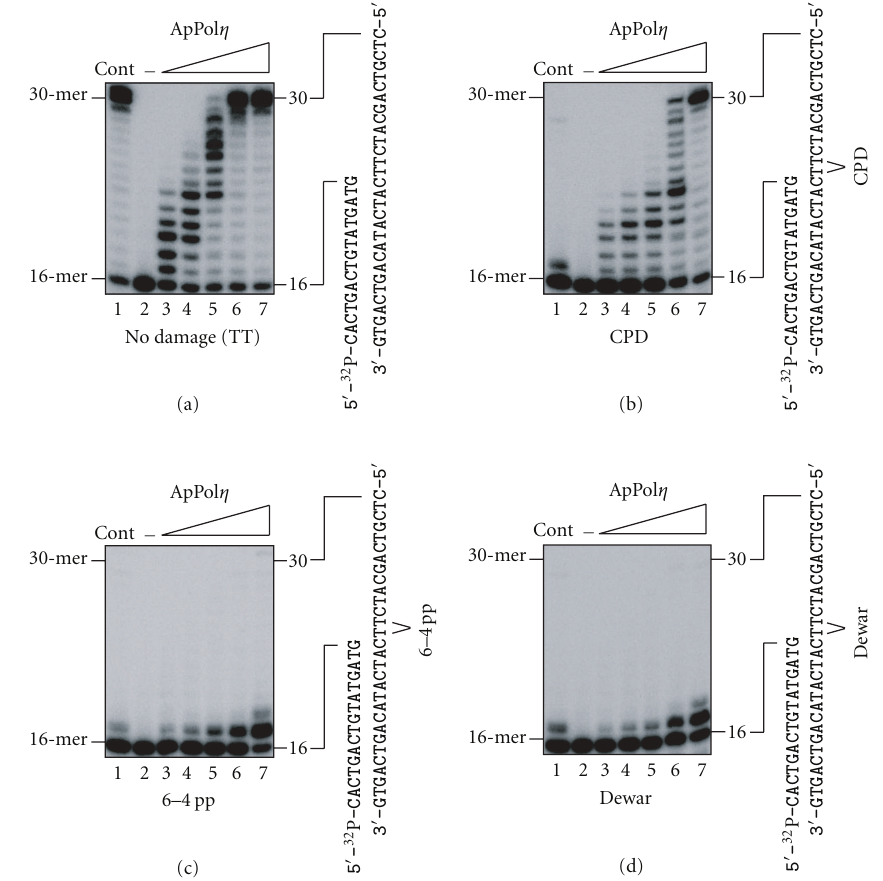
Figure 3: TLS by ApPol η past CPD, 6–4 pp, and Dewar. Increasing amounts of ApPol η (12, 24, 59, 118, and 588 fmol in lanes 3–7, resp.) were incubated with 40 nM of the primer-templates indicated beside each panel. The templates contained undamaged TT (a), CPD (b), 6–4 pp (c), and Dewar (d). The samples for lanes 1 and 2 contained 0.1U KF and no enzyme, respectively. The reactions were incubated at 37 ◦ C